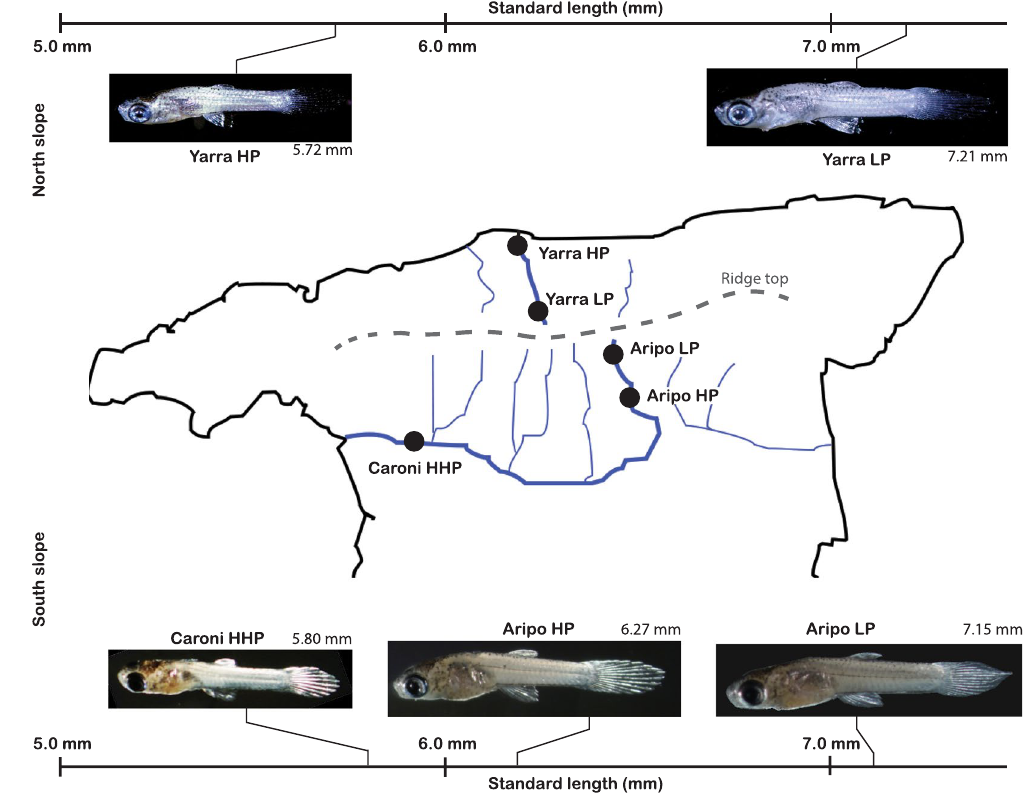
Figure 1. Geographic locations and average neonatal size among five Trinidadian guppy populations in the Northern Range Mountains. Repeated evolution of large offspring size has occurred in low-predation (LP) localities on both the northern (Yarra drainage) and the southern slopes (Caroni and Aripo drainages). The Caroni HHP exhibit an extremely high-predation (HHP) phenotype relative to Aripo HP. Standard length (SL) is defined as a straight line drawn from the tip of the lower jaw (mouth closed) to the base of the tail (caudal peduncle). Adobe Illustrator CS6 (Version 16.0.4; http://www.adobe.com/products/illustrator.html) was used to generate the